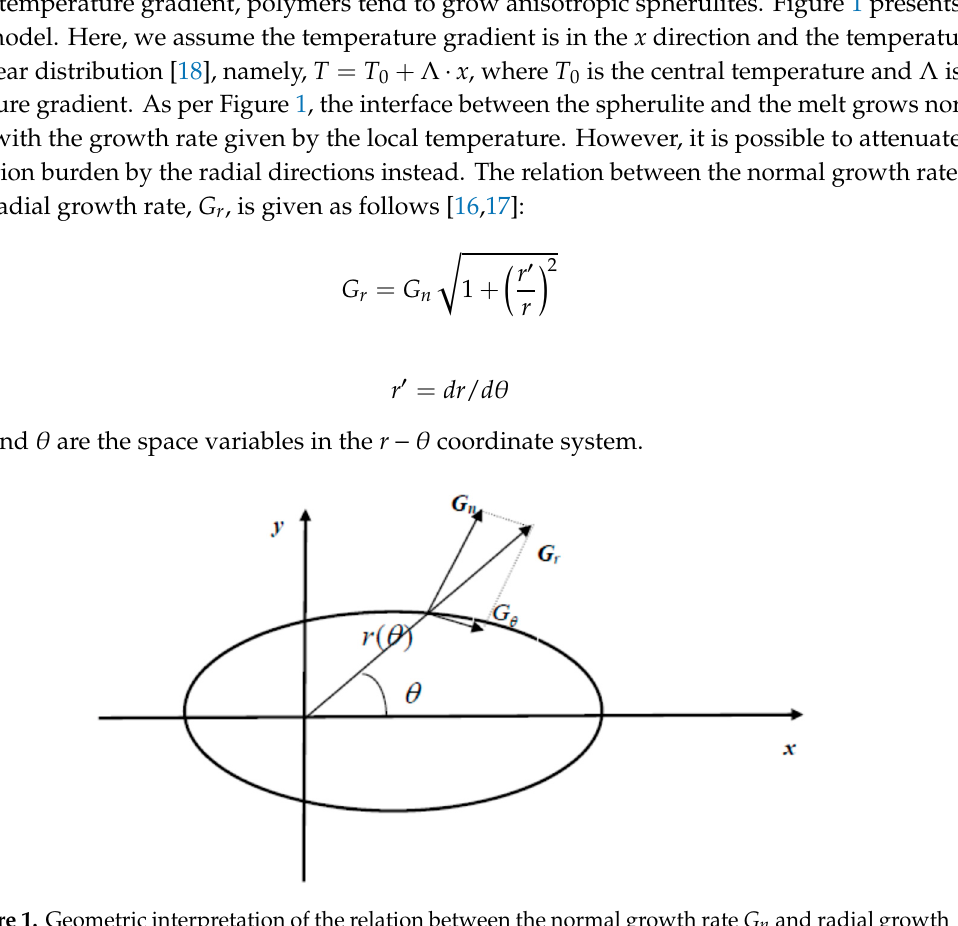
Figure 1. Geometric interpretation of the relation between the normal growth rate G n and radial growth rate G r.